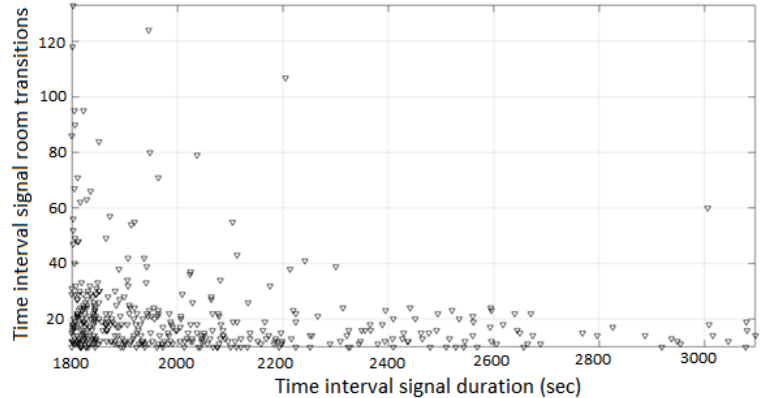
Figure 9. Signal duration (s) vs. number of room transitions, in the time-interval